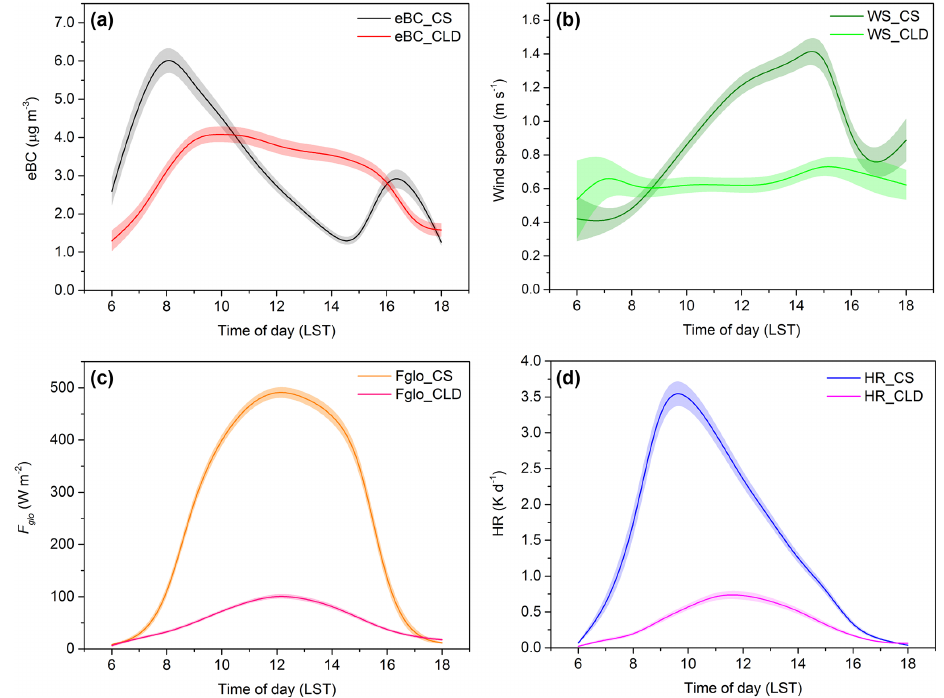
Figure 10. Diurnal pattern of eBC (a) , wind speed (b) , global irradiance ( F glo ) (c) and HR (d) . Data are averaged for clear-sky conditions (CS; 0 oktas) and cloudy conditions (CLD; 7–8 oktas).